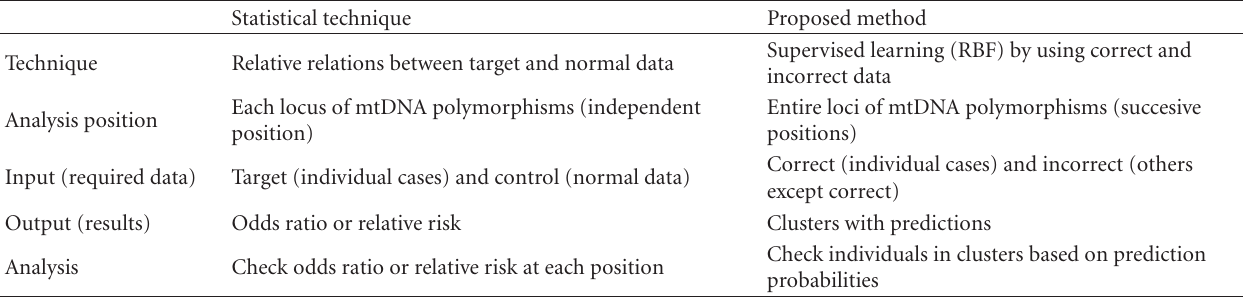
Table 4: Di ff erences between the statistical technique and the proposed (modified RBF)